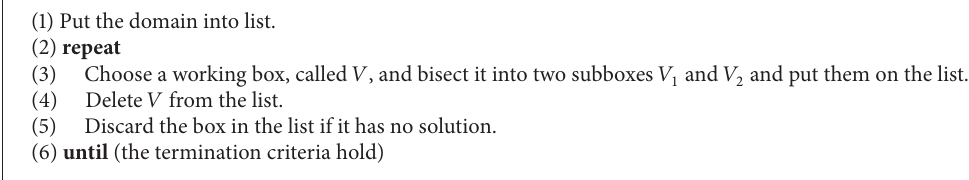
Algorithm 1: Interval branch and bound